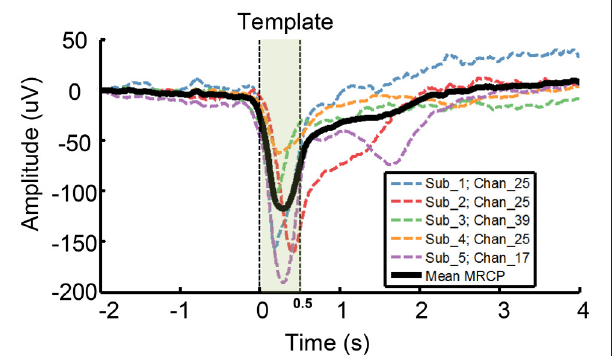
FIGURE 1 | Template used for ETAM method. A representative grand average MRCP waveform was chosen from each subject, i.e., channel 25,25,39,25,17 from subject 1–5, respectively. Each dash line indicates a single channel grand average MRCP waveform, and the bold solid line, i.e., the Mean MRCP, indicates the average of the five representative channel MRCPs. The template (shadow area) is a 500 ms segment of the mean MRCP from 0 to 500